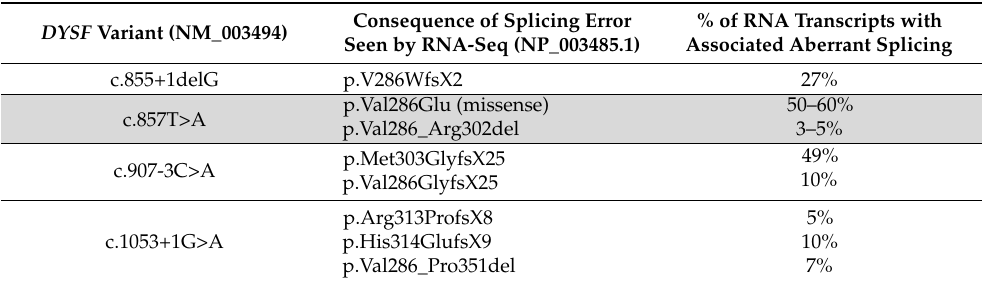
Table 1. 27 DYSF variants that cause splicing errors as determined by